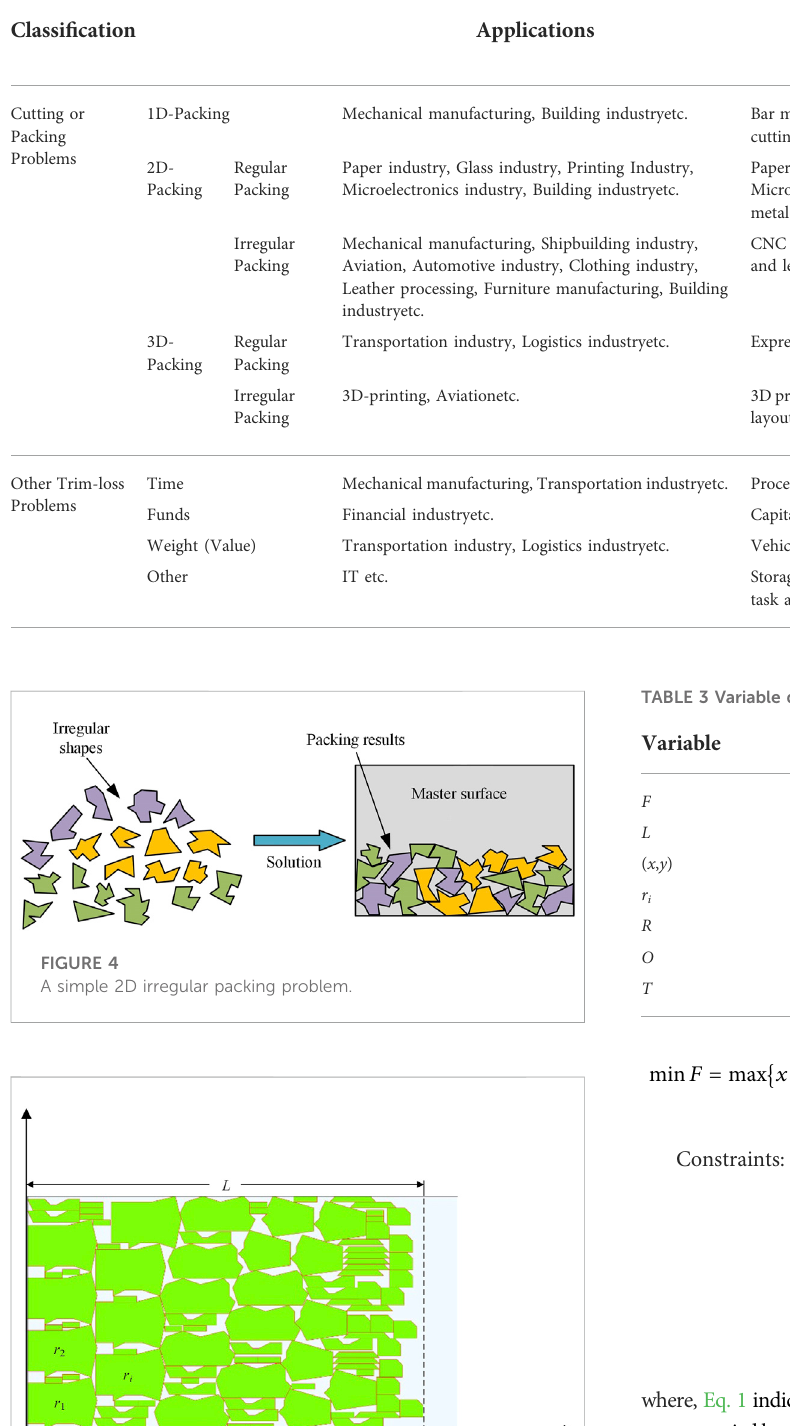
TABLE 2 Classi fi cation of packing problems and their applications.